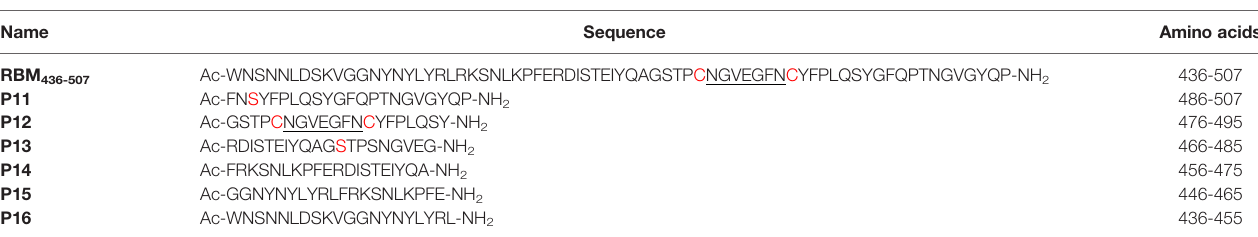
TABLE 1 | Synthesized RBM peptide